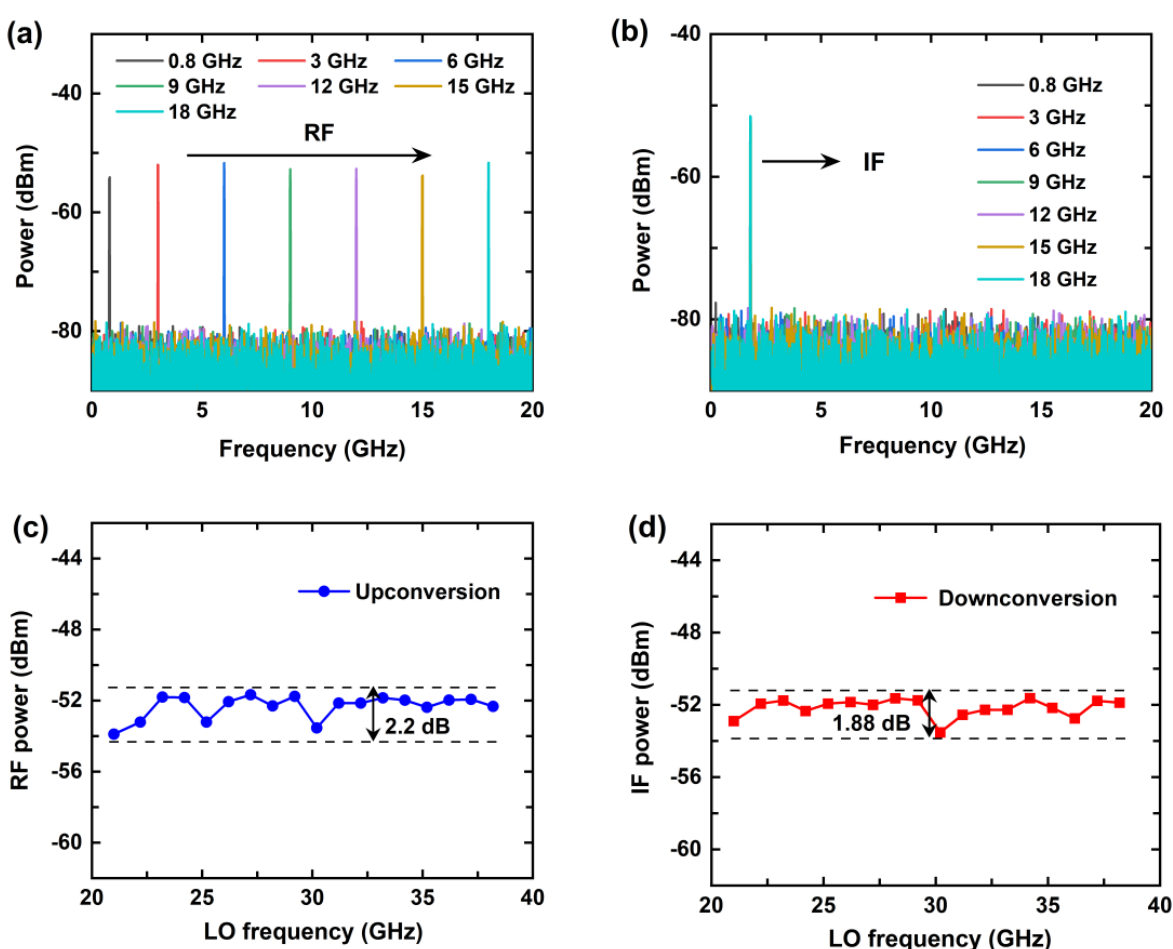
Figure 4. Simulated electrical spectrum of upconversion ( a ), downconversion ( b ), and output power of RF ( c ), IF ( d ) signal when RF signal is tuned from 0.8 to 18 GHz.